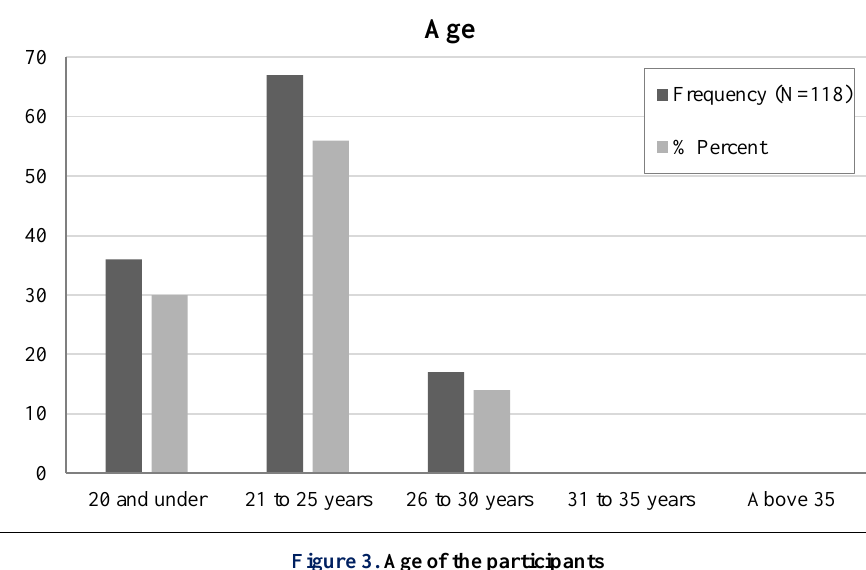
Figure 3. Age of the participants